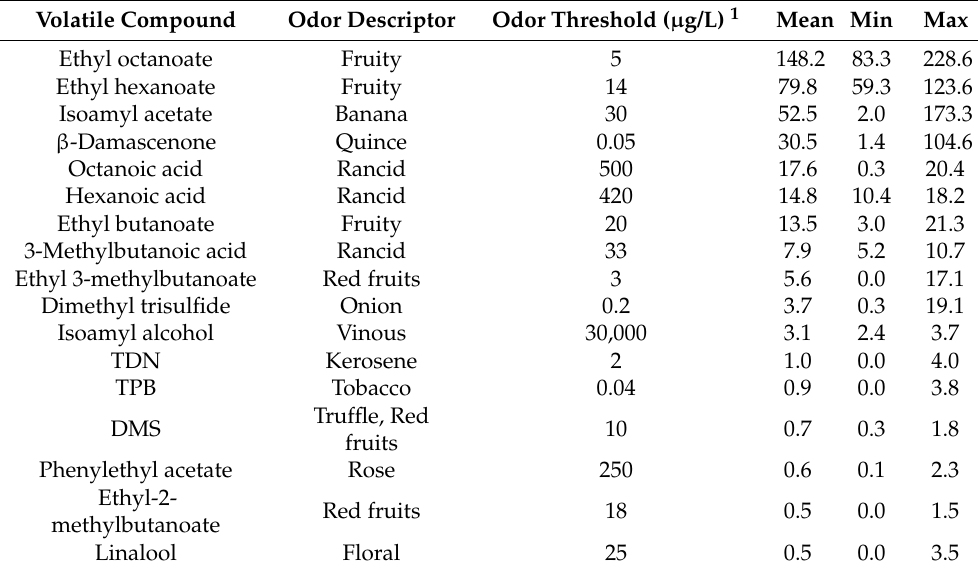
Table 4. Odor activity values of aroma compounds in Prosecco wines with at least one sample showing OAV >